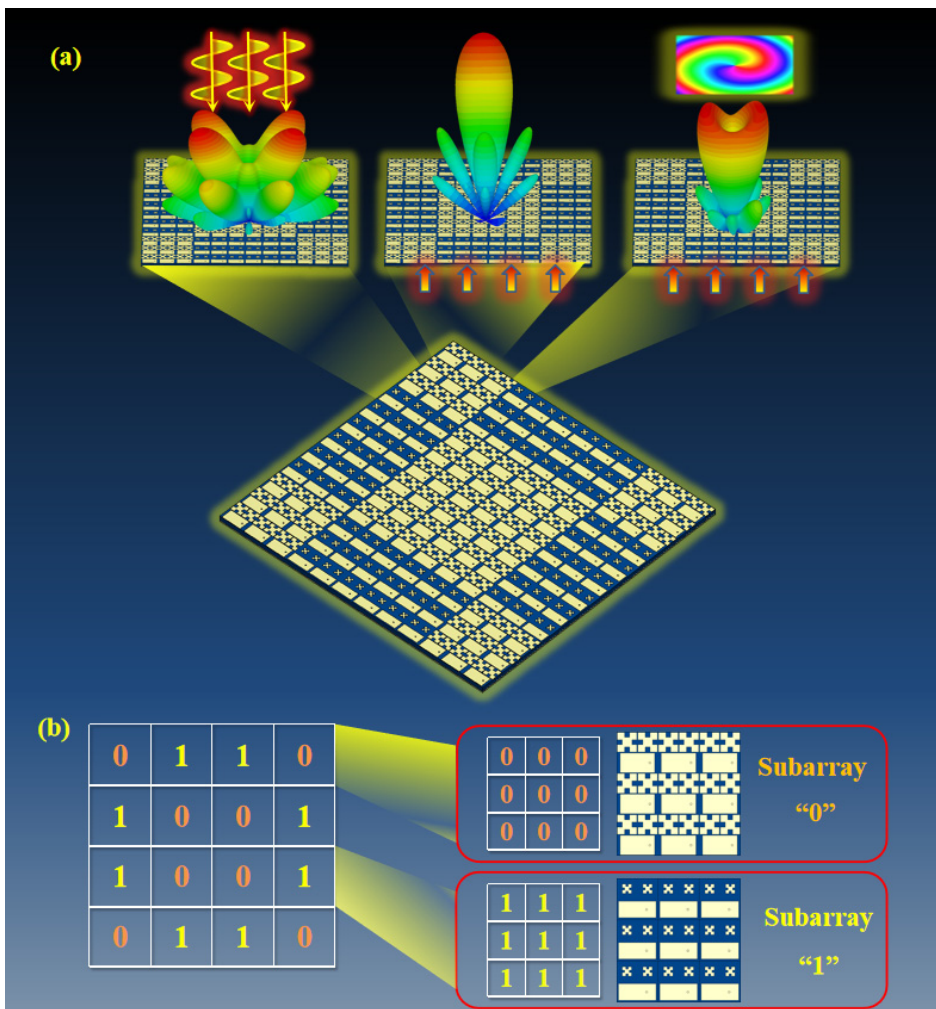
Figure 1. Schematic diagram of the CFMS with the multiple functions of RCS reduction, high-gain radiation, and OAM generation. ( a ) The functions of scattering beam modulation, high-gain radiation, and OAM generation. ( b ) Coding matrix of the CFMS based on subarray ”0” and subarray “1”. The F4B with ε r = 2.65 and tan δ = 0.0013 was chosen as the substrate. The rectangular radiation patch, two quasi-Minkowski patches, and ground were all copper, with a thickness of 0.036 mm and conductivity of 5.8 × 10 7 S/m.